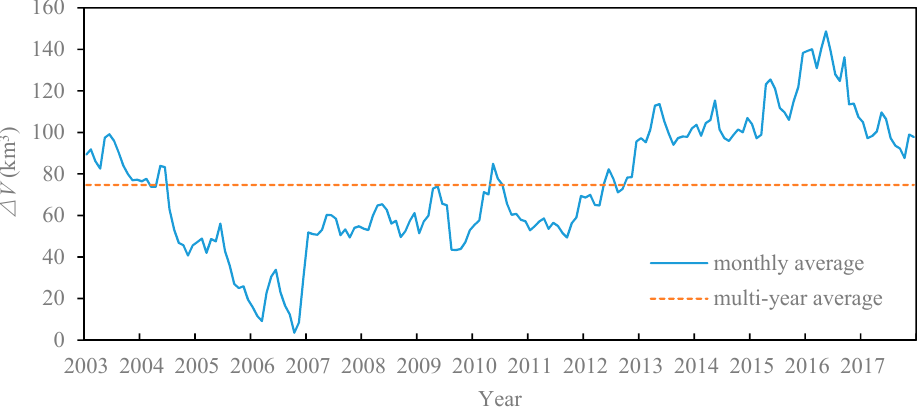
Figure 11. Monthly water volume variations time series of Lake Victoria (2003–2017).